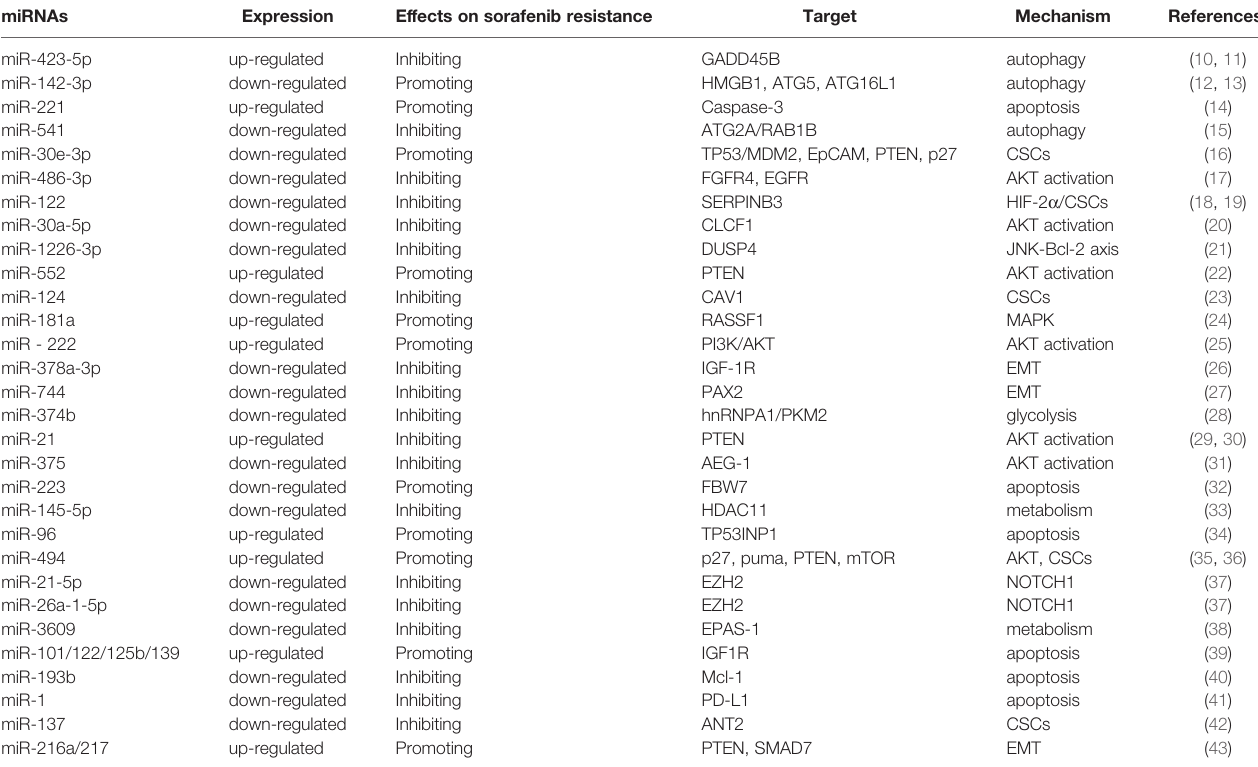
TABLE 1 | miRNAs and sorafenib resistance in HCC.